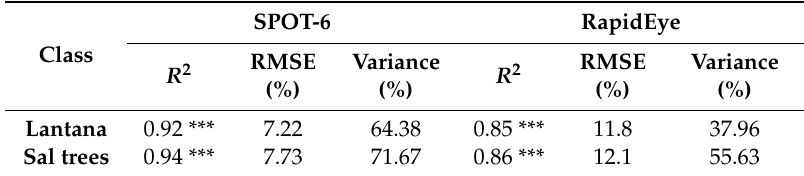
Table 5. Fractional cover statistics for lantana and forest classes. Probability of significant relevance codes are 0.05 < p : ***, p <